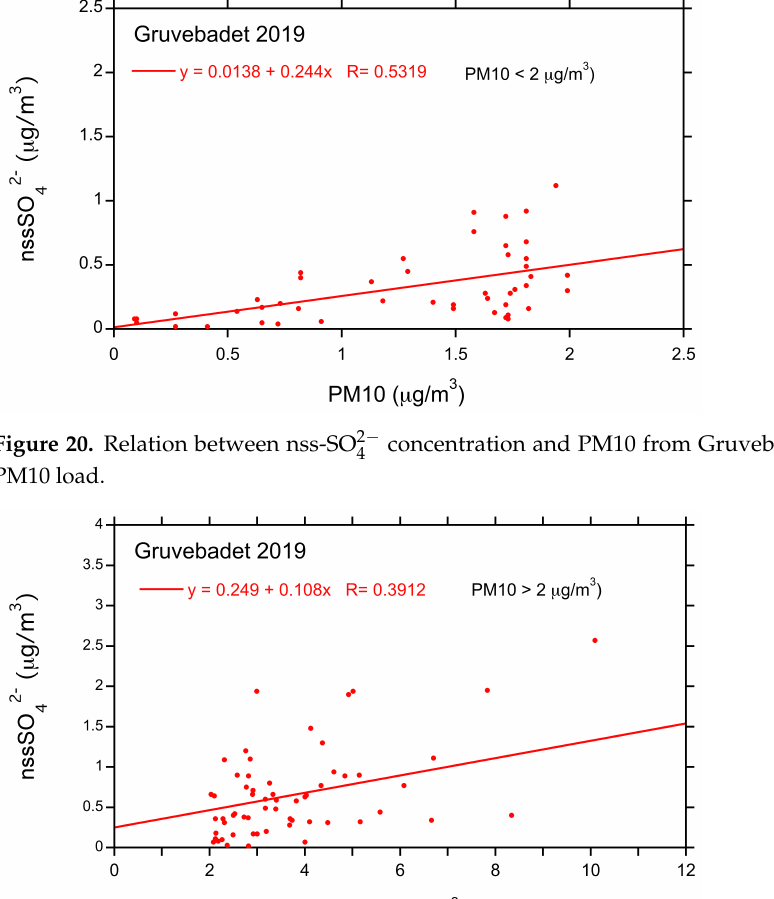
concentration at both in situ sites. 4